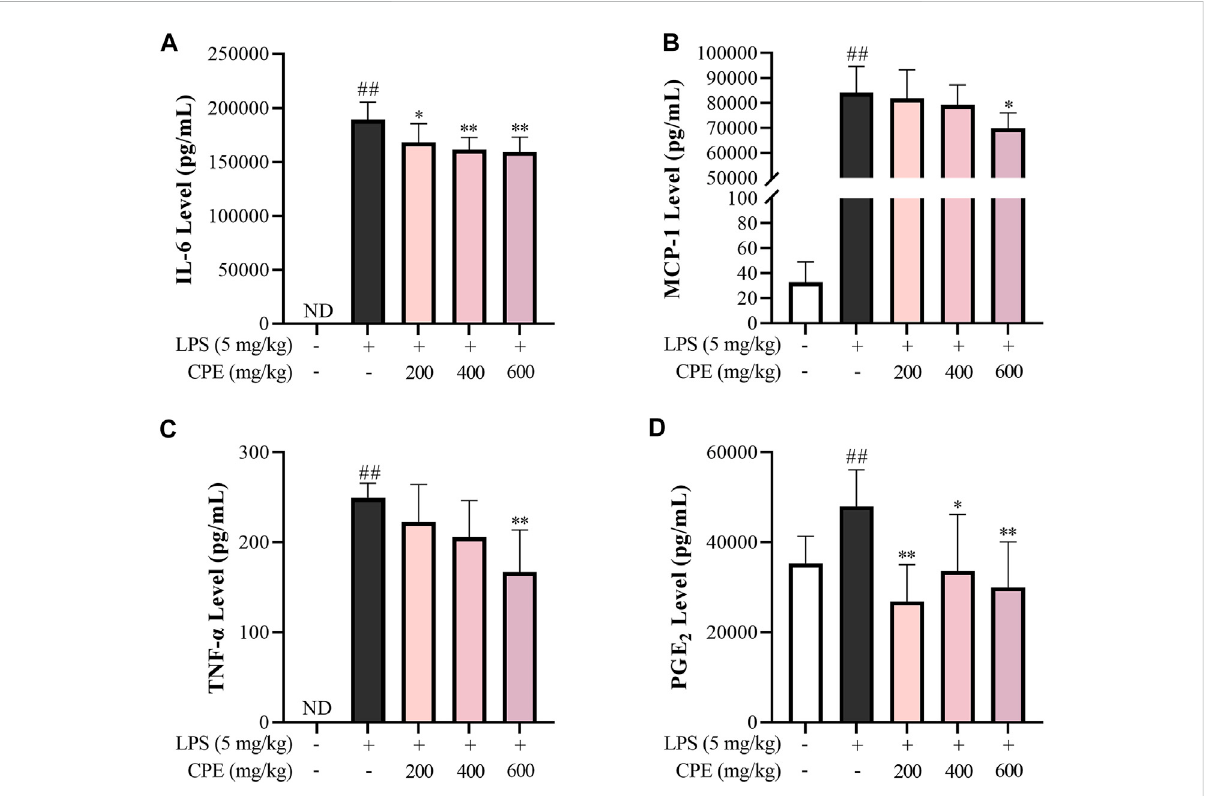
FIGURE 9 Effect ofCPE on endotoxemia mice( n = 8).The male C57BL/6 mice wereadministratedCPE ( i.p. )immediately after LPSinjection( i.v. ).2 hlater, the blood was collected. The levels of IL-6 (A) , MCP-1 (B) , TNF- α (C) , and PGE 2 (D) in serum were measured by ELISA. ## p < 0.01 vs. normal control group; * p < 0.05 and ** p < 0.01 vs. model group. ND, not